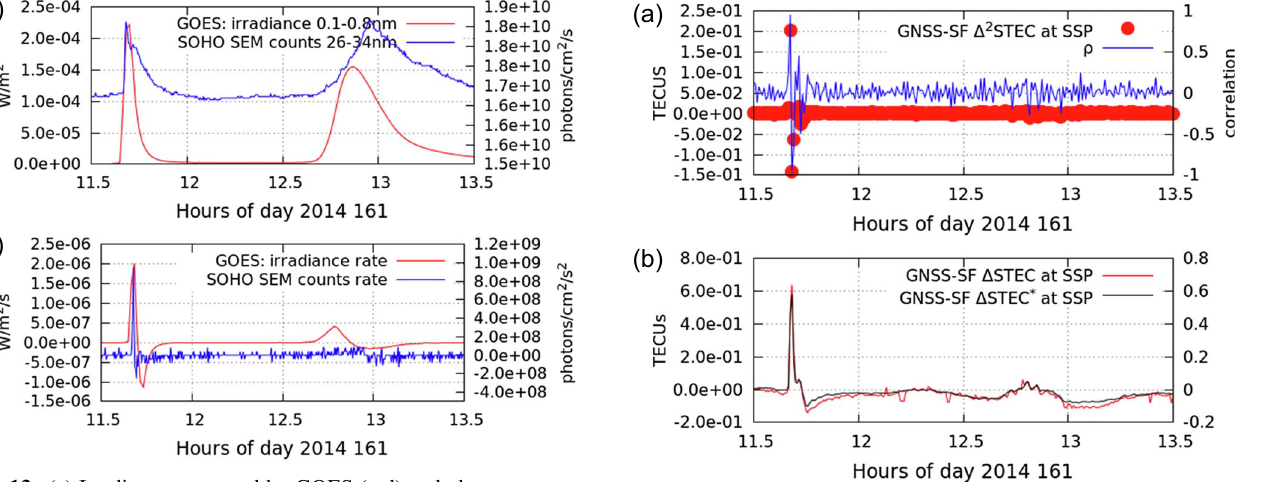
Fig. 13. (a) Irradiance measured by GOES (red) and photons counts measured by SOHO SEM (blue) during DoY 161 (June 10) in 2014. Fig. 14. STEC variations for DoY 161 (June 10) in 2014 from the same GNSS data as those of Figure 13. (a) D 2 2STEC (red) and q (blue) at the SSP. (b) D STEC (red) and D STEC* (integrated from D 2 2STEC) (black).